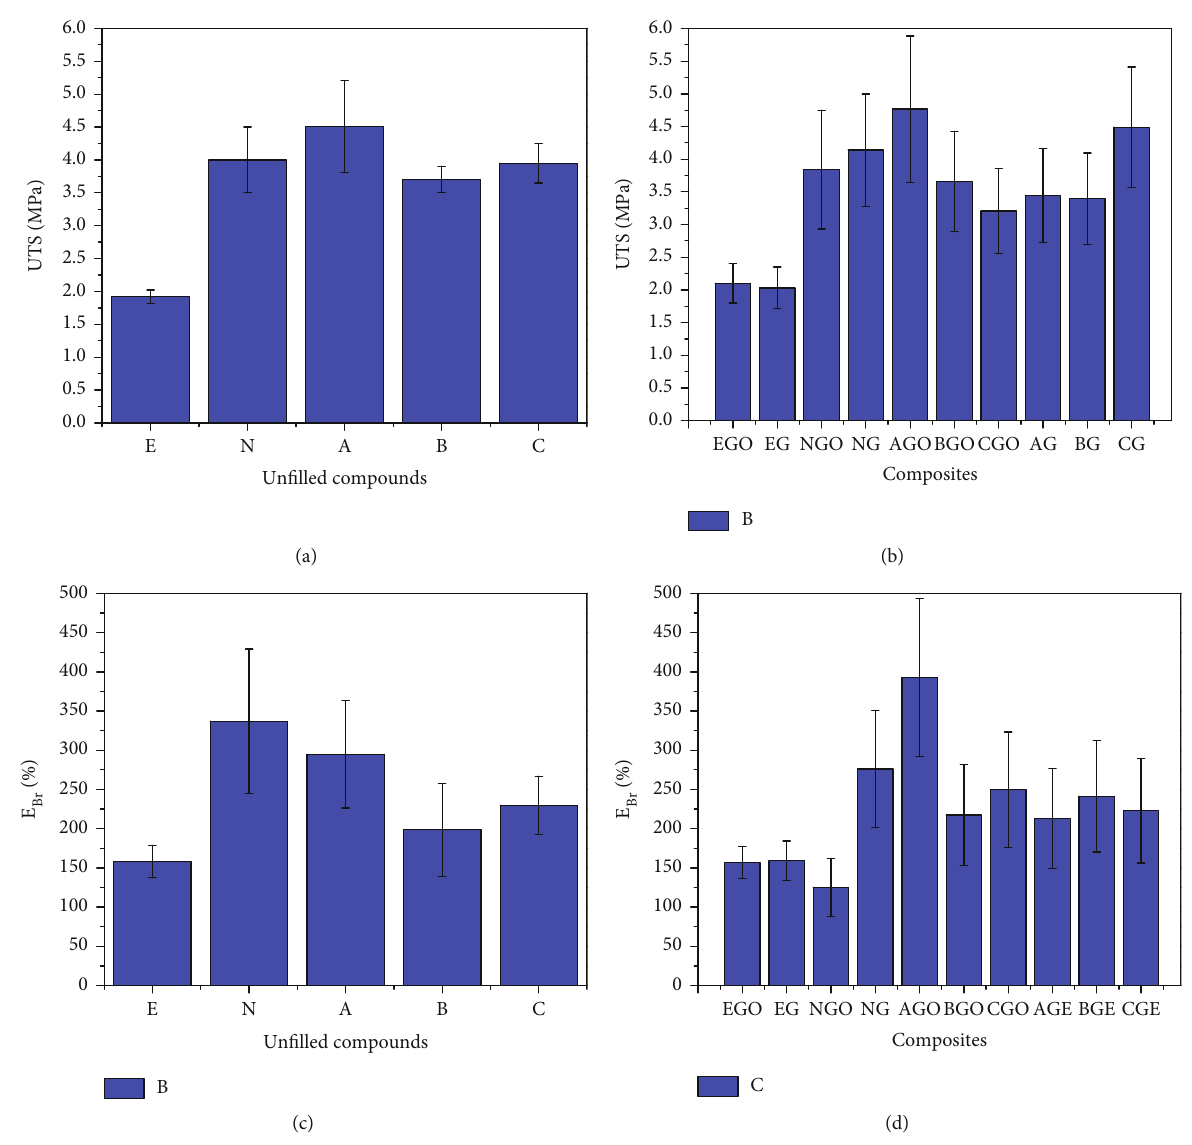
Figure 8: Tensile properties of un fi lled and fi lled compounds/blends. (a) Tensile strength of un fi lled-single and double matrix; (b) tensile strength of single and double matrix- fi lled GO and G; (c) elongation at break of single and double matrix- fi lled GO and G; (d) elongation at break of single and double matrix- fi lled GO and